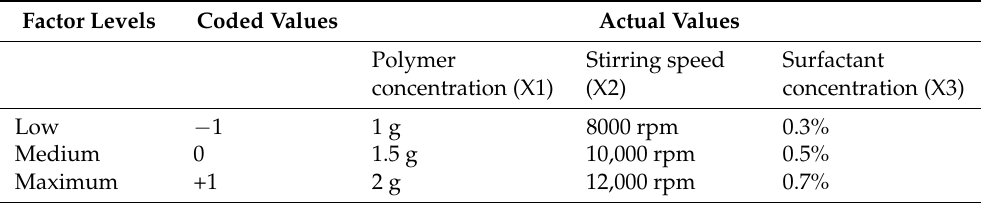
Table 2. Composition of the independent variables, 3 factors with 3 levels. Factor Levels